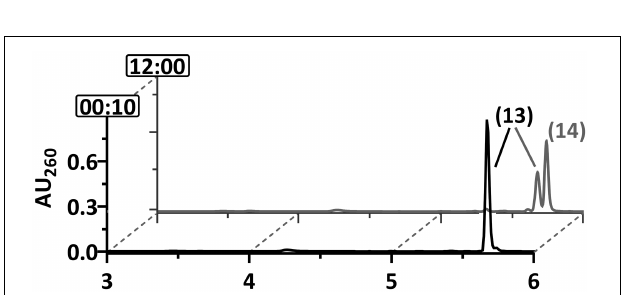
the 2-F-1,5-dienoyl-CoA). OAH is highly conserved in all